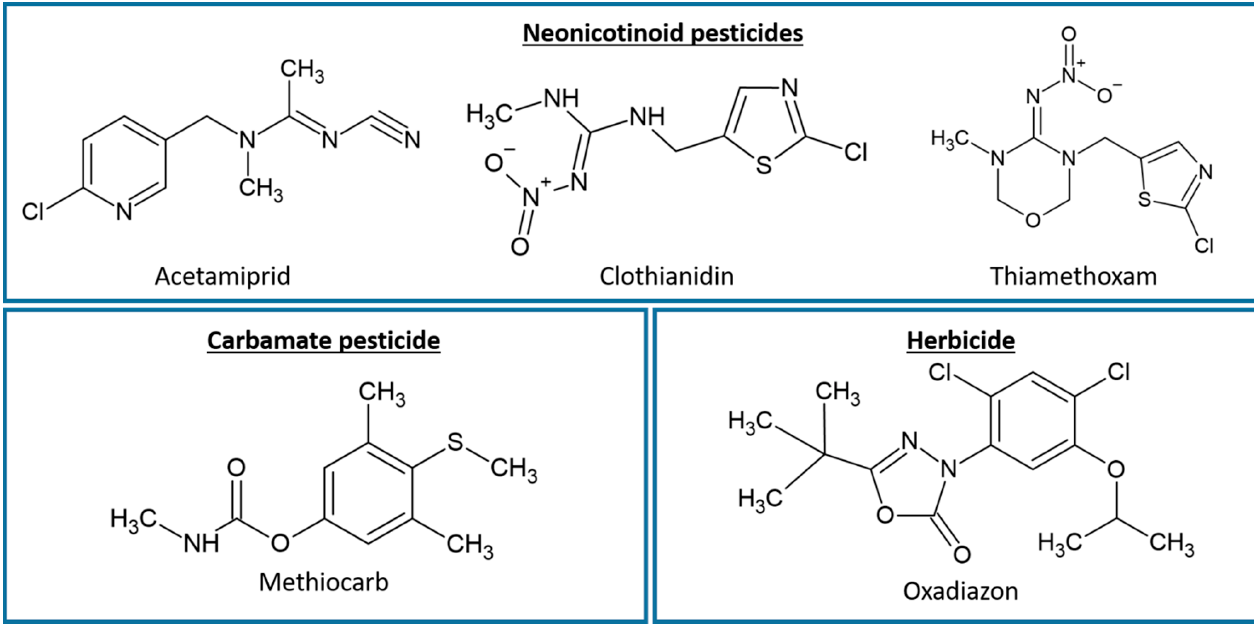
Figure 1. Molecular structures of the five tested pesticides.